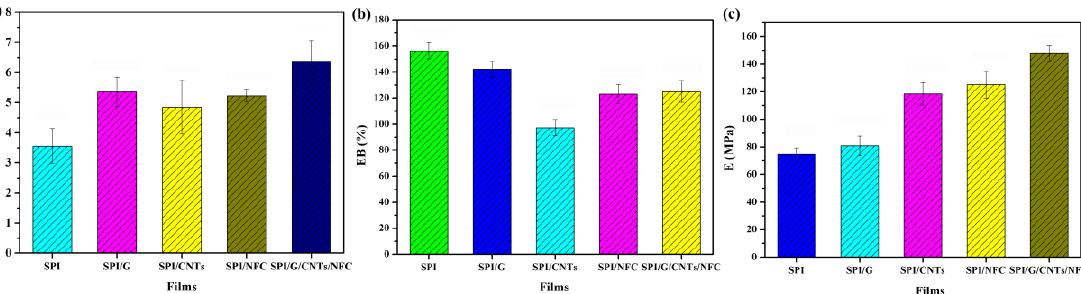
Figure 6. The mechanical properties of ( a ) tensile strength (TS), ( b ) elongation at break (EB), and ( c ) Young’s modulus ( E) of SPI-based nanocomposite films. Table 2. The thickness, TS, EB, and E values of SPI-based nanocomposite films.